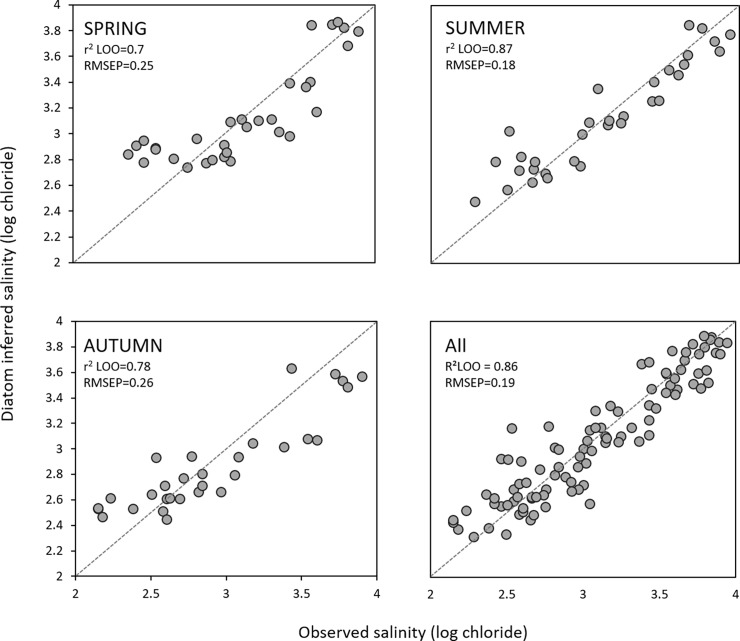
Diatom salinity inference models (WA-PLS) showing the relationship between observed and predicted salinity under leave-one-out cross validation for spring, summer, autumn and ¨all-seasons¨ combined.